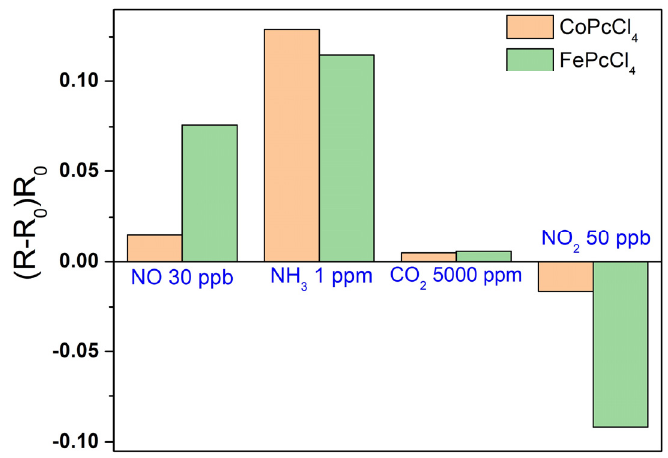
Figure 12. Sensor response of FePcCl 4 and CoPcCl 4 films to NO (30 ppb), NH 3 (3 ppm), and CO 2 (5000 ppm) and NO 2 (50 ppb).